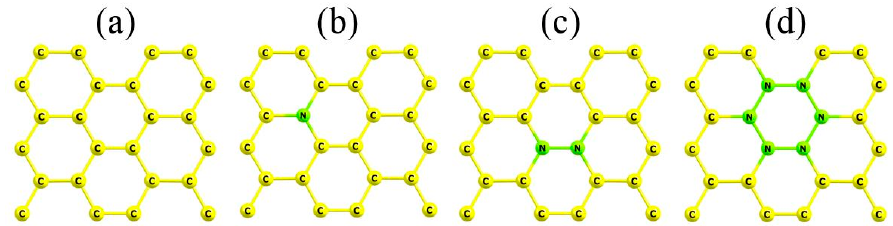
Figure 1. Periodic cells for the models of pristine ( a ) and nitrogen-doped ( b – d )